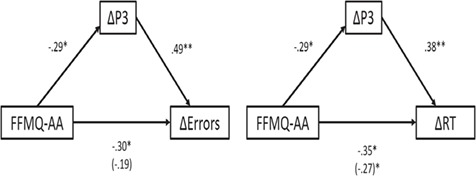
Mediational models depicting the relationship between trait mindfulness (FFMQ-AA) and the congruency (incongruent–congruent) difference in errors (Δ errors) and RT (Δ RT), as mediated by the congruency difference in P3 amplitude (ΔP3). The value in the parentheses indicates the relationship between FFMQ-AA and Δ errors and Δ RT after controlling for ΔP3 amplitude. Statistical significance is demarcated by asterisks (*P < 0.05, **P < 0.01).